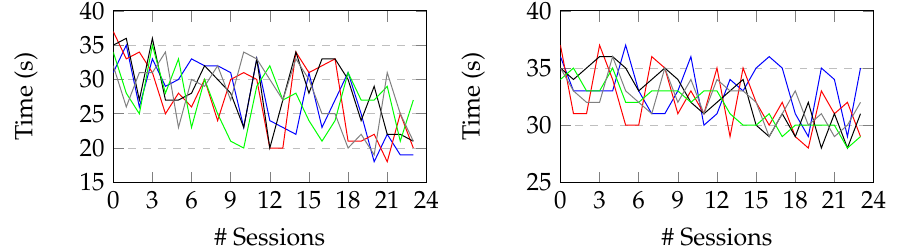
Figure 8. Evolution of the follow the path activity at ADACEA ( left ) and at the nursing home ( right